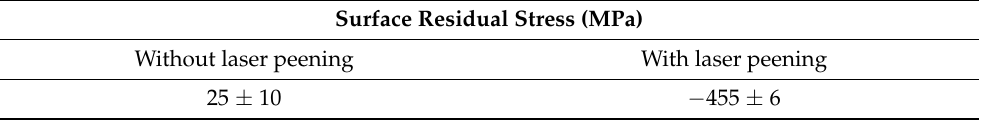
Table 3. Result of residual stress measurement.